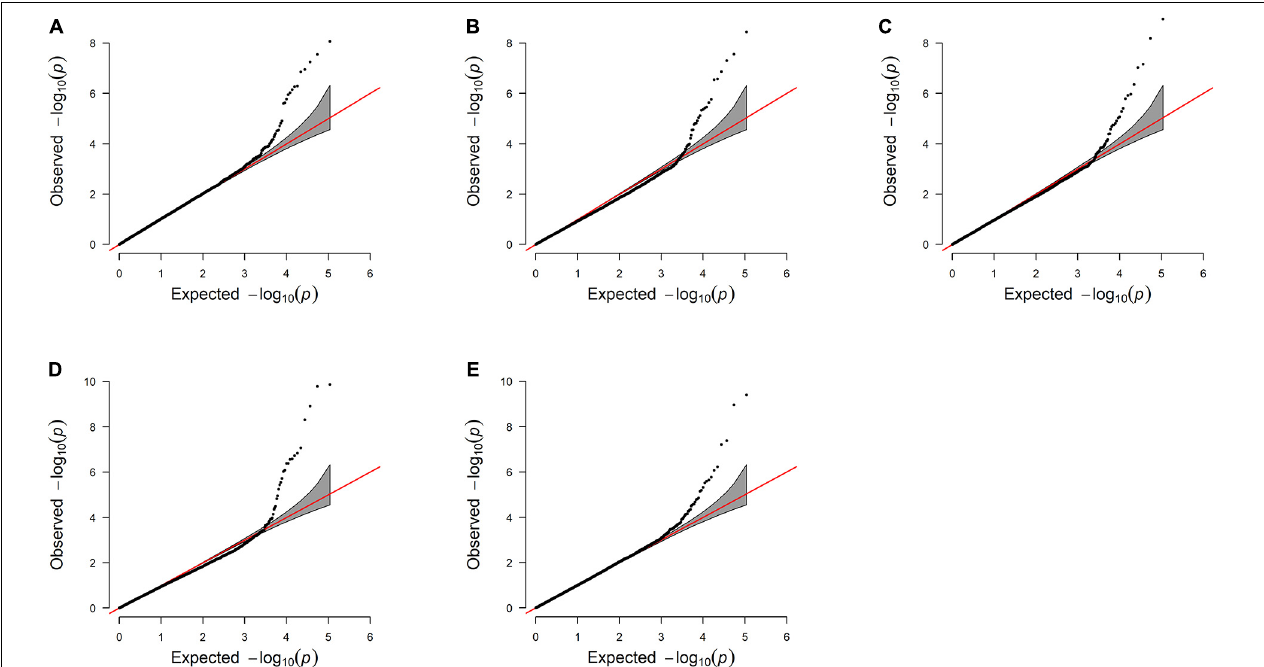
FIGURE 3 | Quantile–quantile plots of genome-wide association studies for genetic effects of the dam on reproductive traits (A–E) . The x -axis and the y -axis represent the expected and observed − log 10 ( P − value ) . (A) Conception rate—the λ value is 1.03. (B) 56-day non-return rate—the λ value is 0.92. (C) Calving ease—the λ value is 0.96. (D) Stillbirth—the λ value is 0.94. (E) Gestation length—the λ value 1.00.